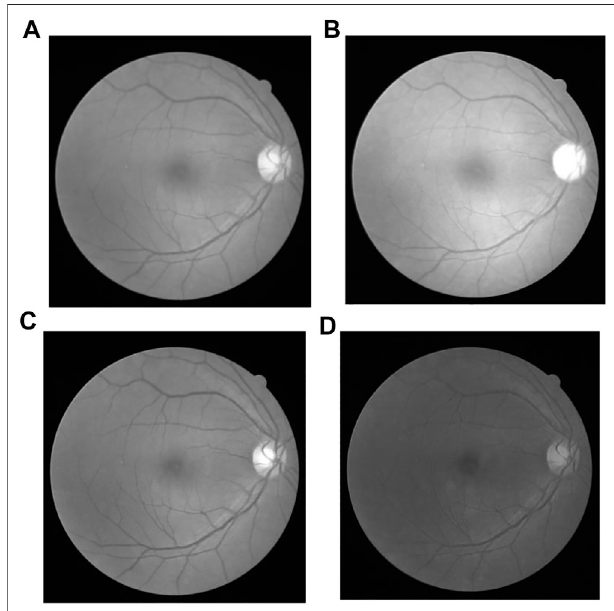
FIGURE 6 | Original Image in different channels: (A) Original gray image, (B) Red channel image, (C) Green channel image, and (D) Blue channel